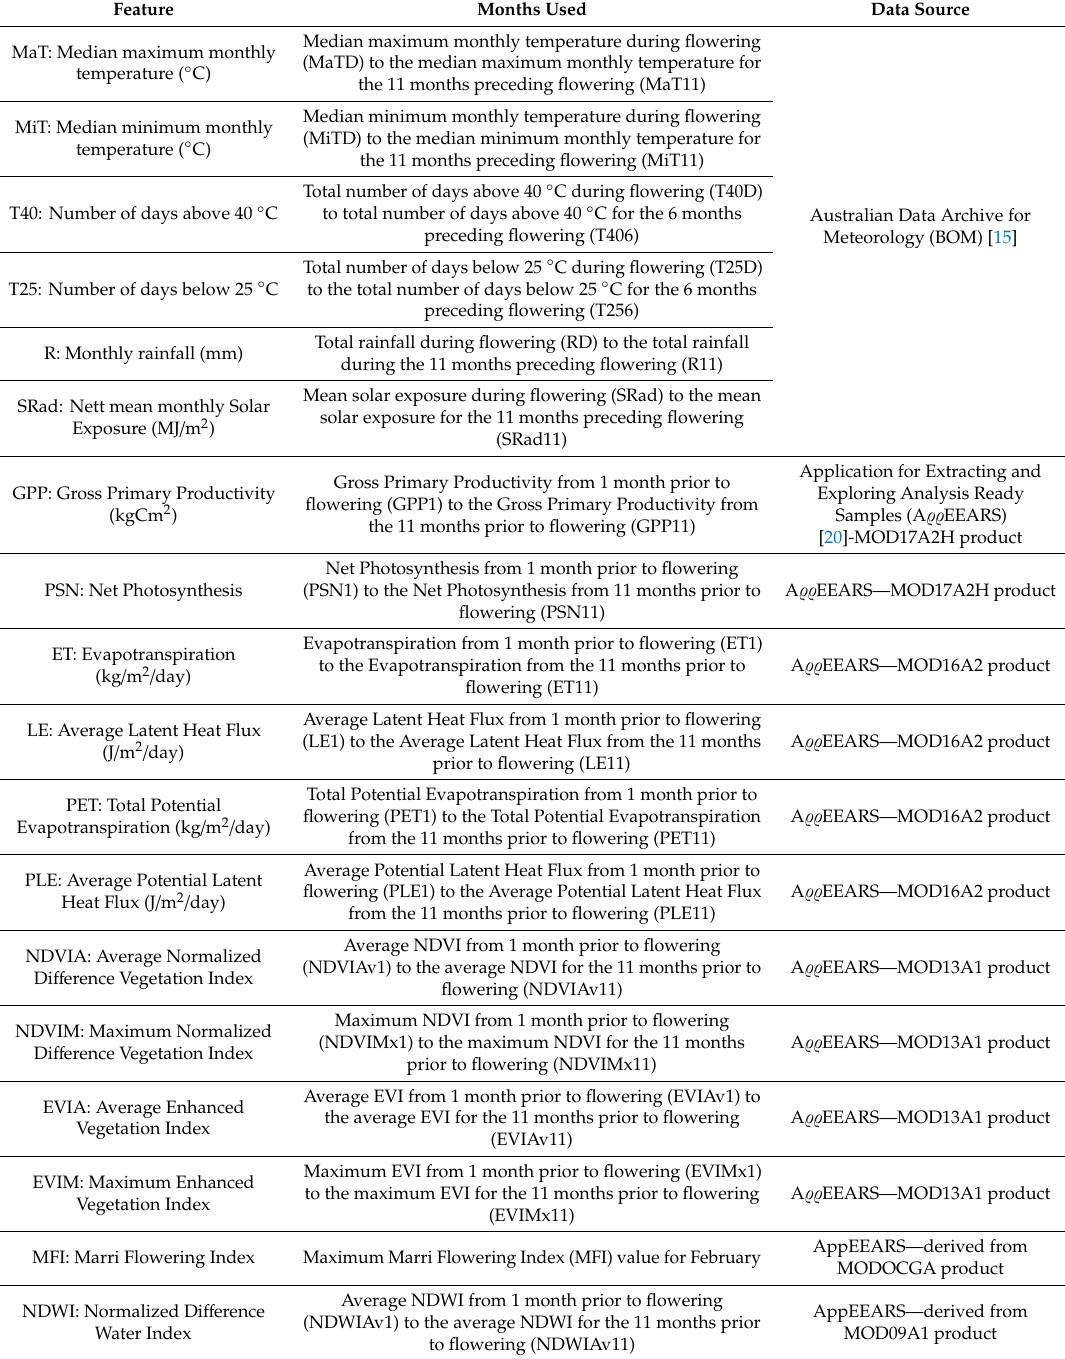
Table 4. Summary of features used in the regression tree